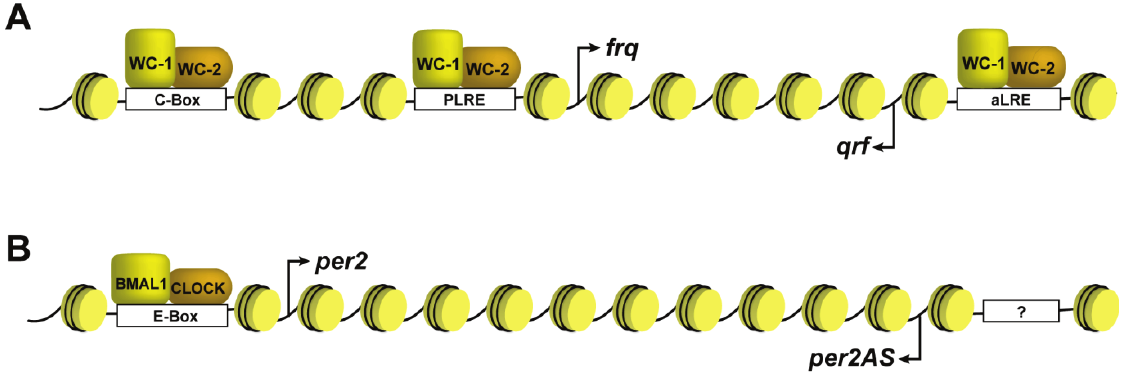
Figure 2. Schematic of the clock genes. Illustration of ( A ) the frq gene in Neurospora and ( B ) the Per2 gene in mammals, shown as the typical “beads on string” with nucleosomes shaded yellow. The figure illustrates the sense and antisense transcripts that originate from both loci. The cis-acting sequences are shown as boxes on the DNA and labeled accordingly. The “?” within the Per2AS promoter indicates that the transcription factors responsible for expression are still unknown. Note that these representations are not drawn to